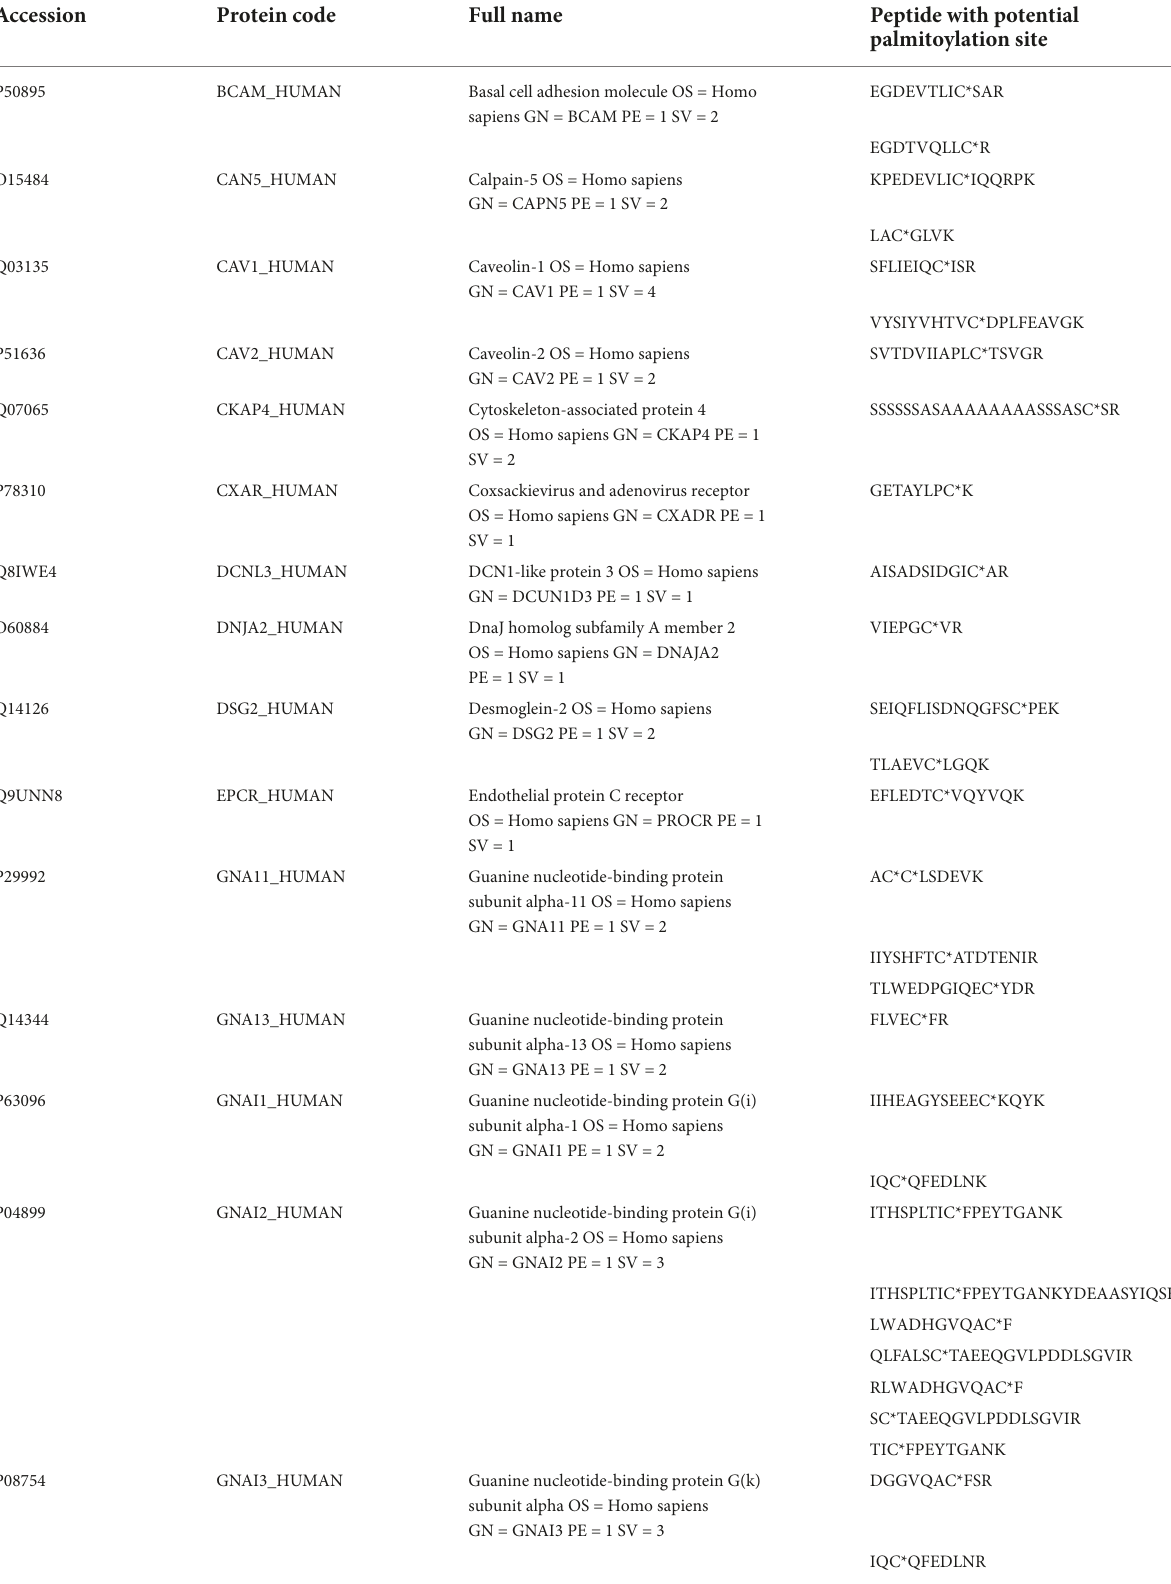
TABLE 2 Proteins and peptides that are identified in both control and 2-BP-treated ARPE-19